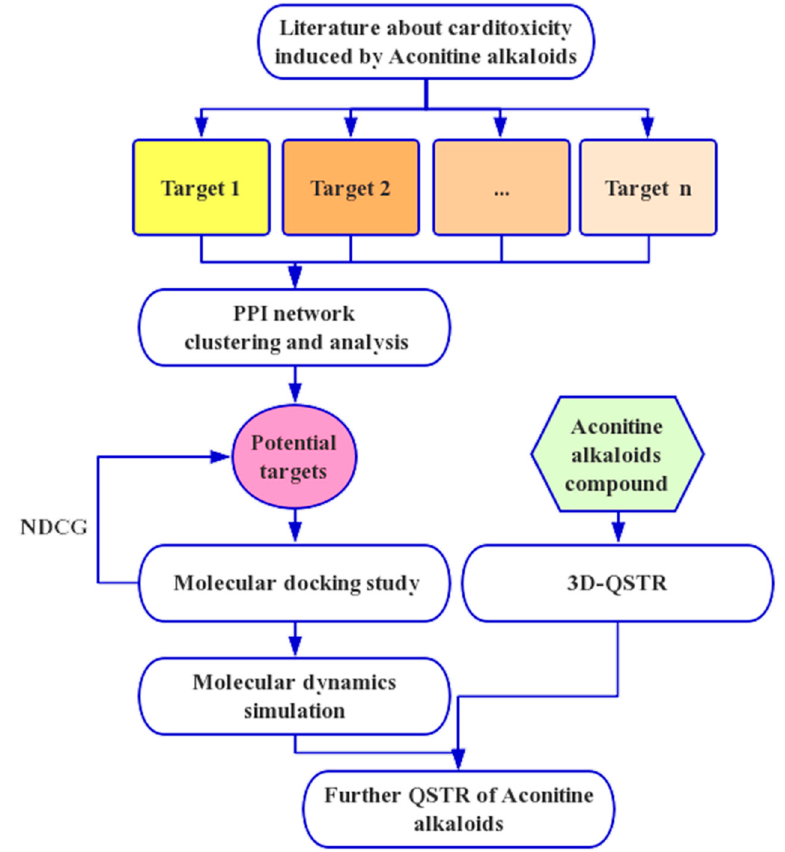
Figure 1. The whole framework of the comprehensive in silico method for screening potential targets and studying the quantitative structure–toxicity relationship (QSTR).